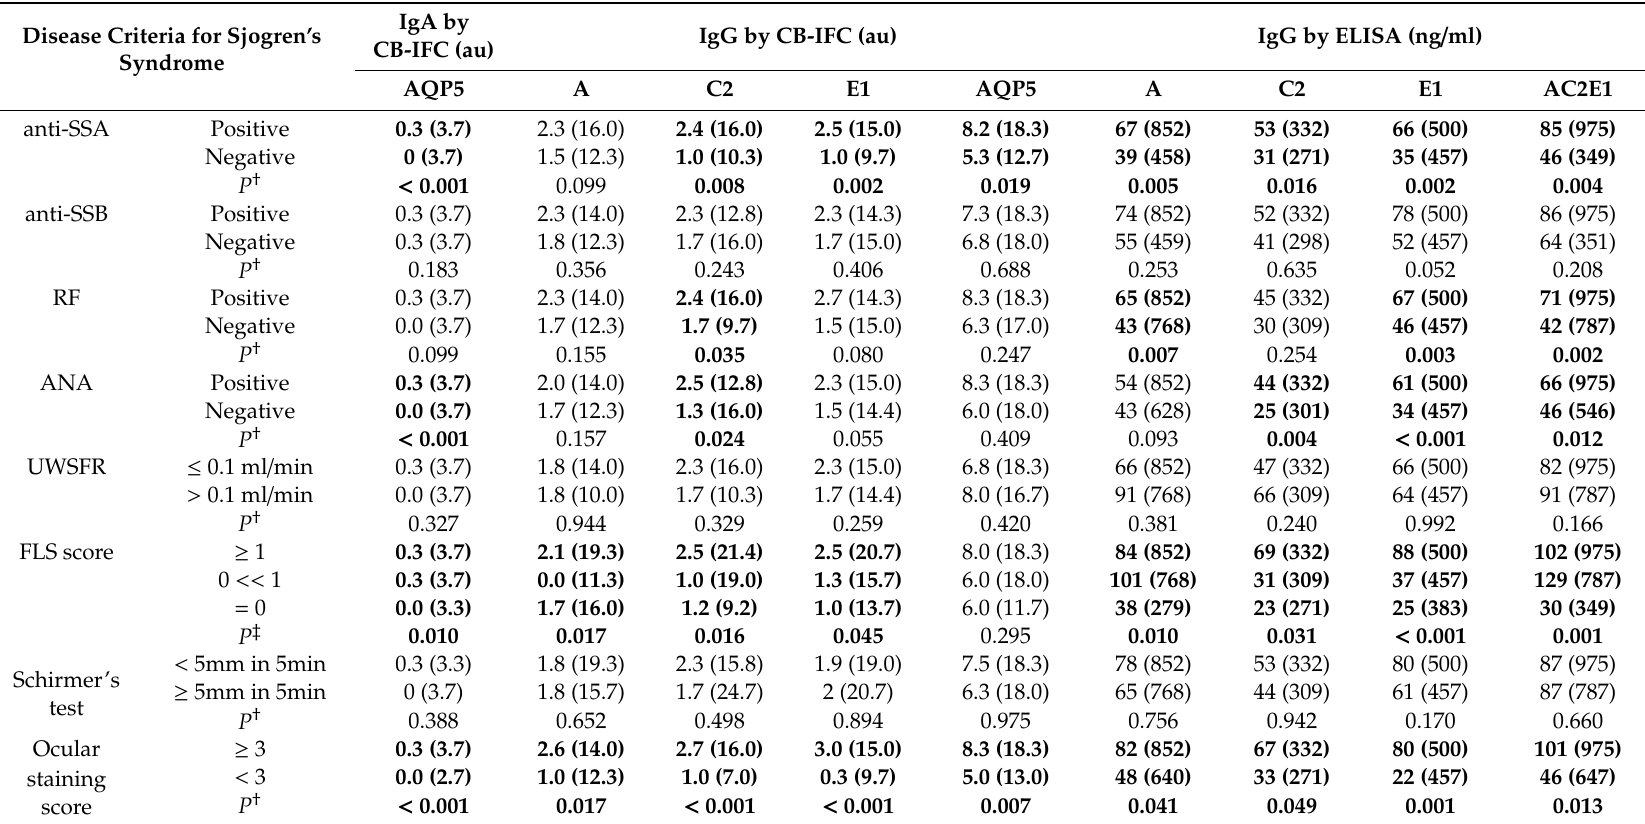
Table 4. Nonparametric approach exploring the presence of anti-AQP5 autoantibodies by disease criteria for Sjögren’s syndrome in 154 SICCA registry samples. Disease Criteria for